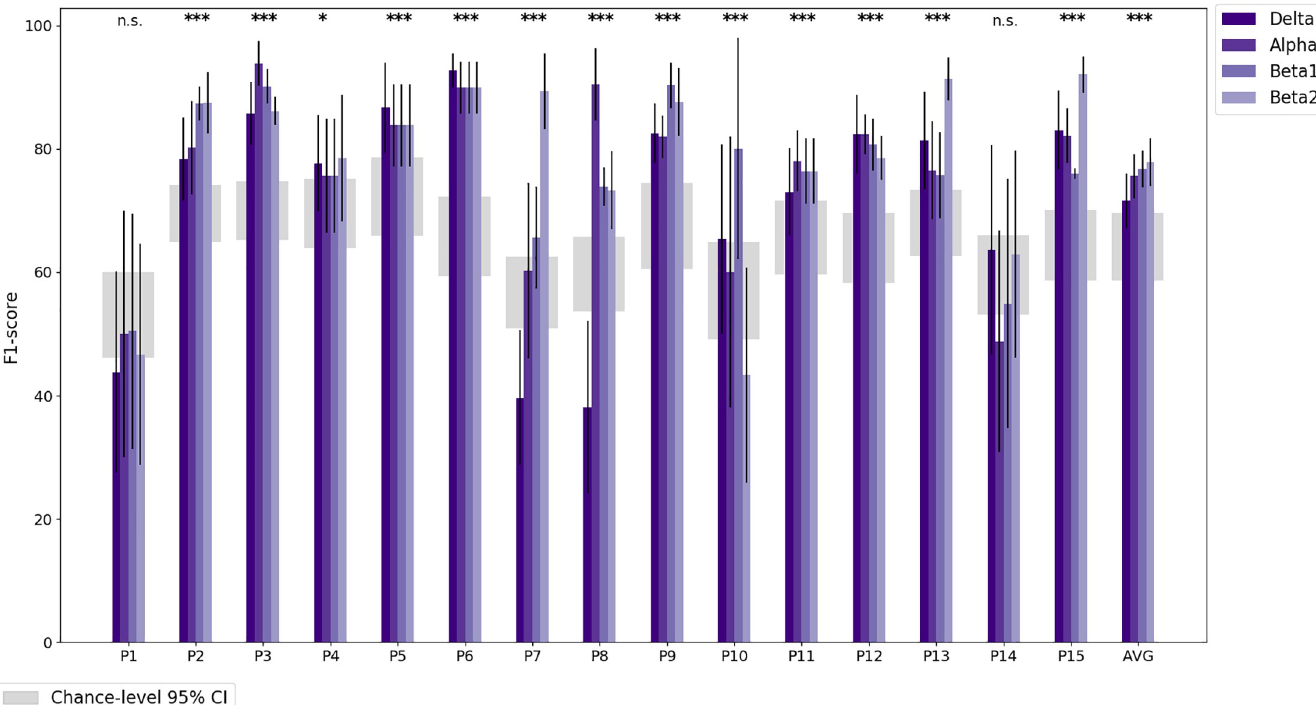
Fig 5. Classification performance for the Artifacts Suppressed approach given by the F1 score for each participant and frequency band. The rightmost set of bars are the averages across participants. Standard error bars are given for five cross-validation runs for each participant and all 15 participants for the averaged accuracies. The 95% confidence intervals for chance-level F1 scores per participant are plotted as grey regions, and statistical significance is calculated using independent two- sample t-tests using the best frequency band. � : p < 0.01, �� : p < 0.001, ��� : p < 0.0001.